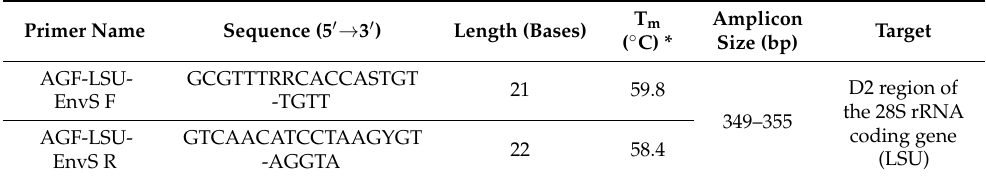
Table 3. Characteristics of the primer pair AGF-LSU-EnvS developed to detect, quantify, and classify Neocallimastigomycetes in environmental